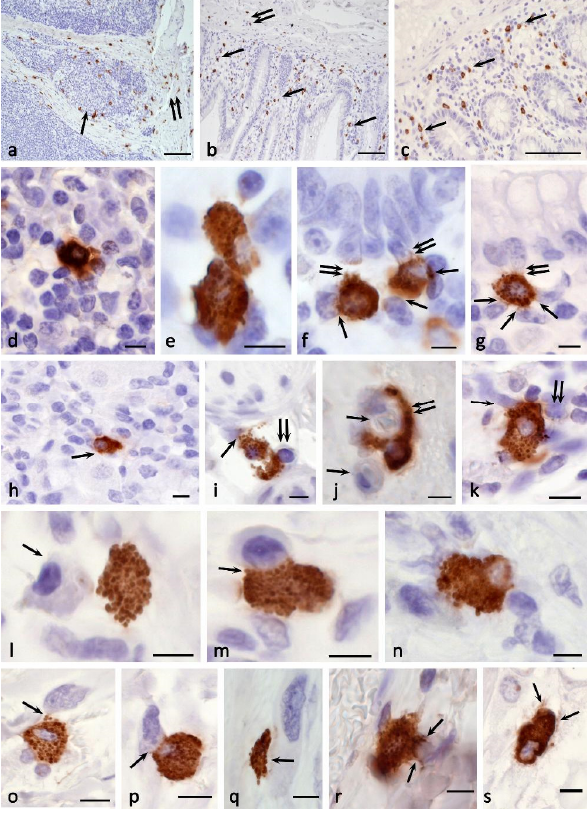
Figure 5. Histotopographic features of the distribution of CPA3 + mast cells in organs. Primary antibodies used: Rabbit polyclonal to CPA3 antibody (ab251696) (AbCam). Secondary antibodies used: AmpliStain anti-Rabbit 1-Step HRP (#AS-R1-HRP), SDT GmbH, label-HRP. ( a ) Tonsil. Localization of CPA3 + MC in the lymphoid tissue (indicated by the arrow) and stroma (double arrow) of the organ. ( b , c ) The jejunum. The location of CPA3 + MC in the mucosa (indicated by the arrow) and submucosa (indicated by the double arrow). ( d ) Tonsilla. CPA3 + mast cell in interfollicular lymphoid tissue. ( e – g ) Jejunum. CPA3 + MC contacting in the lamina propria of the mucous ( e ), interaction with stromal cells (indicated by an arrow) and epithelium (indicated by a double arrow) of the mucous ( f , g ). ( h – i ) Stomach. CPA3 + MC in the stroma of the lamina propria of mucosa, colocalization with the parietal cell of the fundic gland (arrow) and stromal cells ( h ). CPA3 + MC degranulates in the direction of the perineurium (indicated by the arrow) and the lymphocyte (double arrow) of the submucosa ( i ). ( j , k ) Skin. Histotopographically, CPA3 + MC is colocalized with two capillaries (indicated by an arrow); however, CPA3 + secretory material selectively surrounds only one of them over a large area of the basement membrane of the endothelium (indicated by a double arrow) ( j ). MC is colocalized with stromal cells; it is obvious that CPA3 can affect several cells simultaneously, including fibroblast (indicated by an arrow) and an immunocompetent cell ( k ). ( l ) Small intestine. The location of CPA3 + MC near the macrophage (indicated by the arrow). ( m ) Small intestine. Interaction of CPA3 + MC and an activated lymphocyte (indicated by an arrow). ( n ) Skin. CPA3 + MC in the tumor microenvironment of melanoma contacts with immunocompetent cells and fibroblast (indicated by an arrow). ( o – q ) Melanoma of the skin. Various variants of colocalization of CPA3 + MC with fibroblasts of the stromal component (indicated by an arrow). Directed exocytosis of CPA3 + secretory granules ( o ), as well as morphological evidence of transgranulation, «kiss-and-run» degranulation and formation of exosomes (possibly) for the secretion of CPA3 to biological targets ( p – q ) are determined. ( r – s ) Skin melanoma. Active participation of CPA3 + MC in remodeling of the fibrous ( r ) and amorphous ( s ) components of the extracellular matrix of the tumor microenvironment (indicated by the arrow). Scale bar: 100 µ m ( a – c ), 5 µ m (the